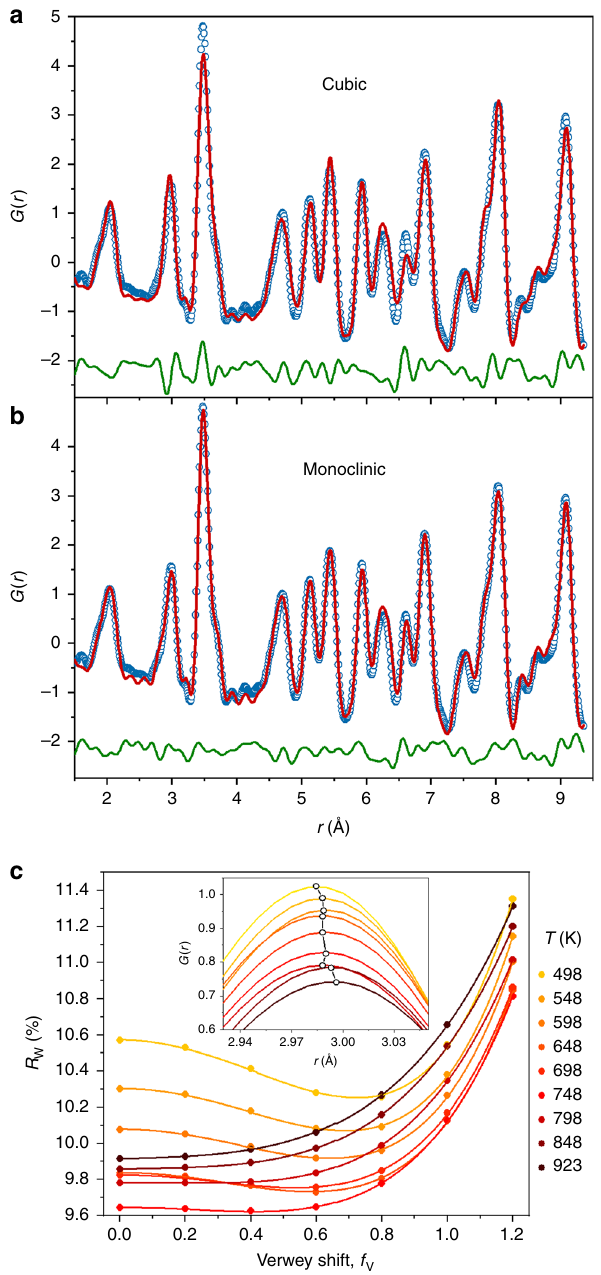
Fig. 2 Fitting of magnetite pair distribution functions (PDFs).